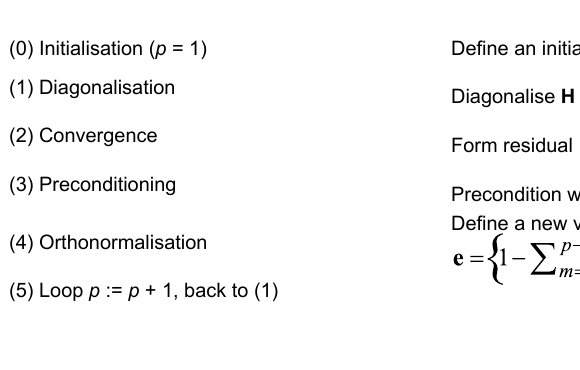
Table 1: Davidson scheme used to converge a specific state The eigenvector is expressed as the VSCF reference state plus the contribution of the excited virtual configurations.